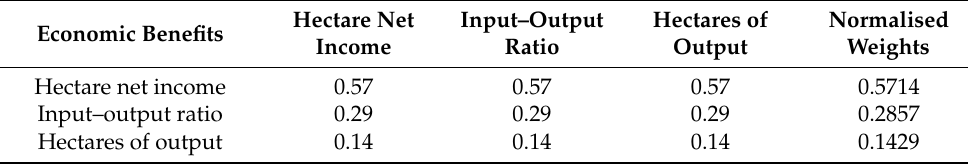
Table 5. Matrix for calculating the weights of economic efficiency indicators and the results of the calculation.